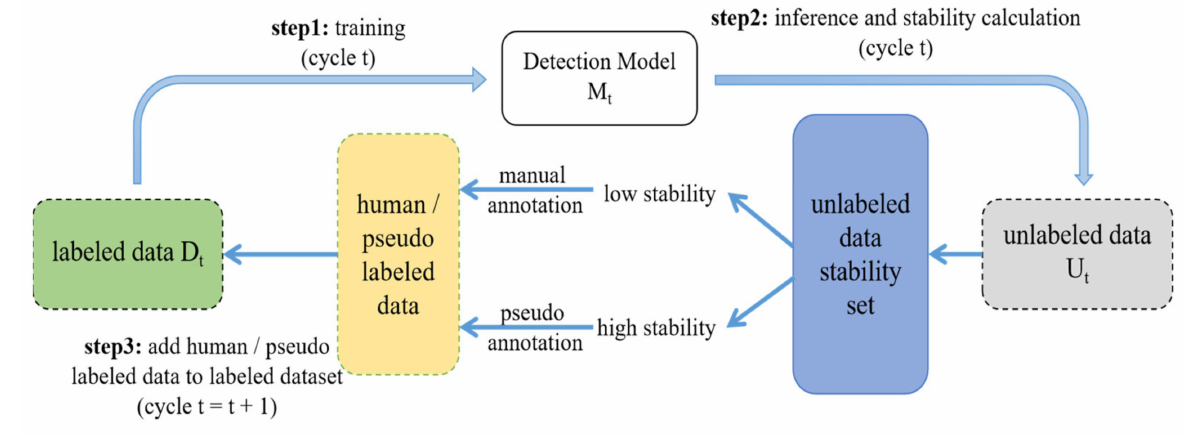
Figure 1. Illustration of the proposed framework at the t-th